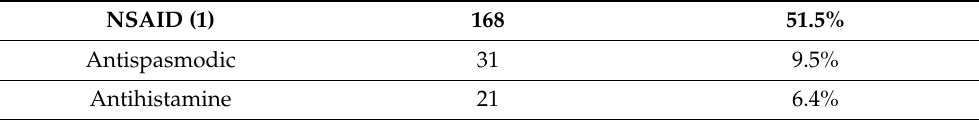
Table 2. Distribution of type of medical treatment (n = 326) of patients who needed medical